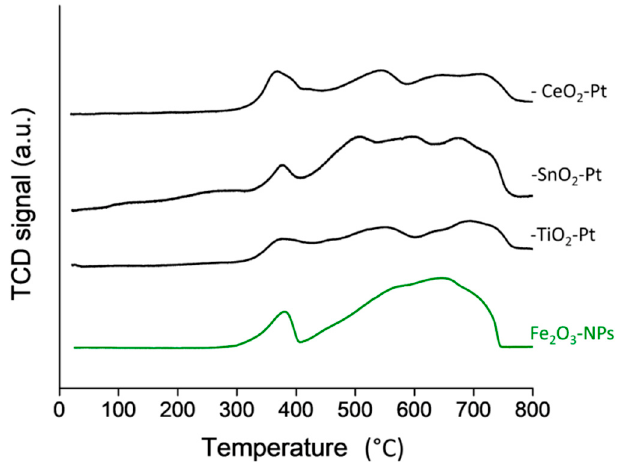
Figure 4. TPR-H 2 profile of Fe 2 O 3 –NPs and Fe 2 O 3 –SiO 2 –MeO 2 –Pt (Me = Ti, Sn, Ce) catalysts.